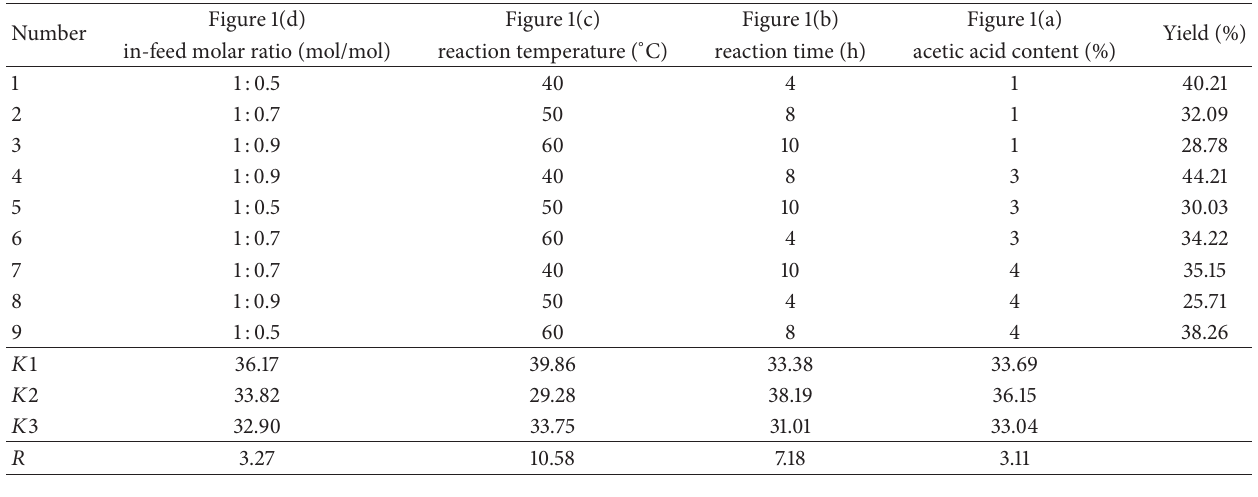
Table 1: Results of orthogonal test.